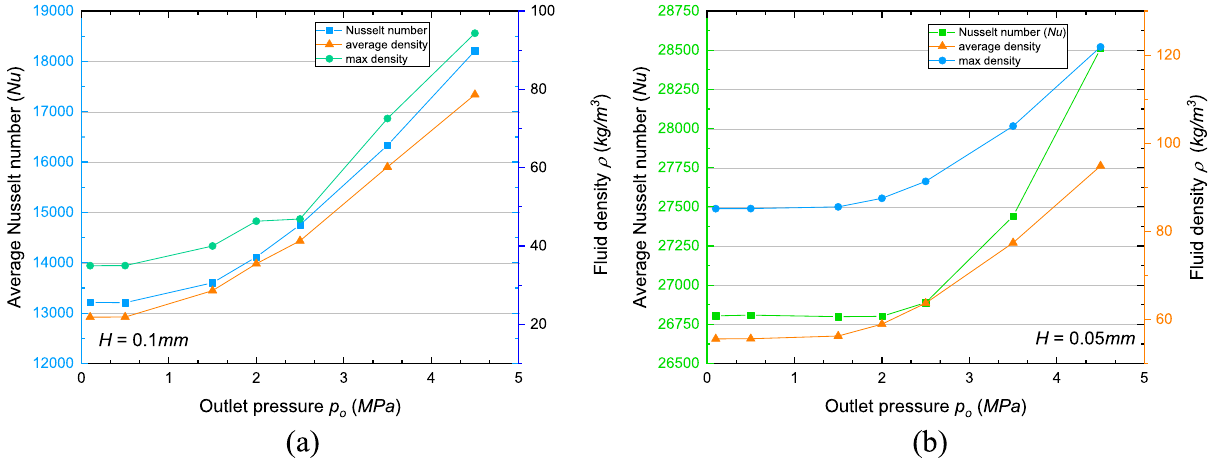
Fig. 16. Variation of average Nusselt number Nu and fl uid density r as functions of outlet pressure po, di=6 mm, q=0.06 kg/s. (a) H=0.1 mm. (b) H=0.05 mm.